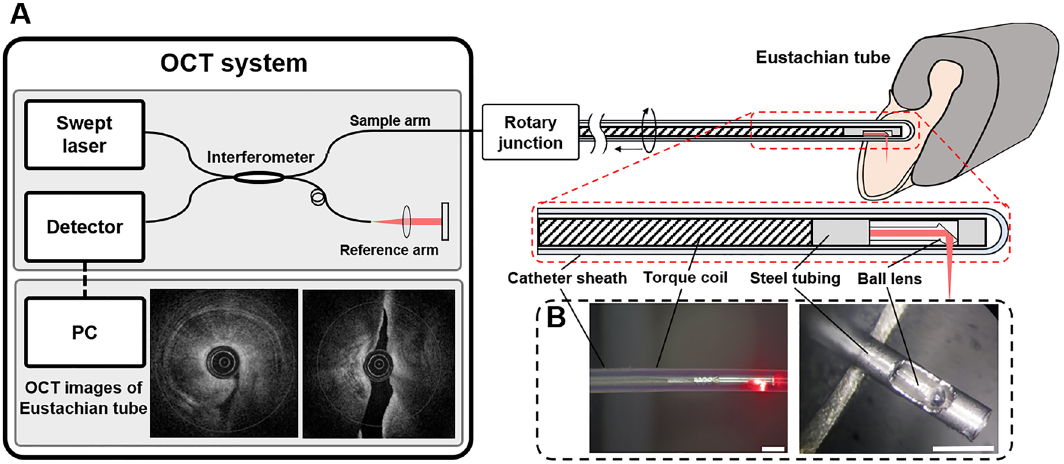
Figure 1. Experimental setup of the Eustachian optical coherence tomography (OCT) system ( A ). Photographs of the OCT catheter ( B ), showing the side view of the catheter ( B , left) and the distal end of the imaging probe without the catheter sheath ( B ,